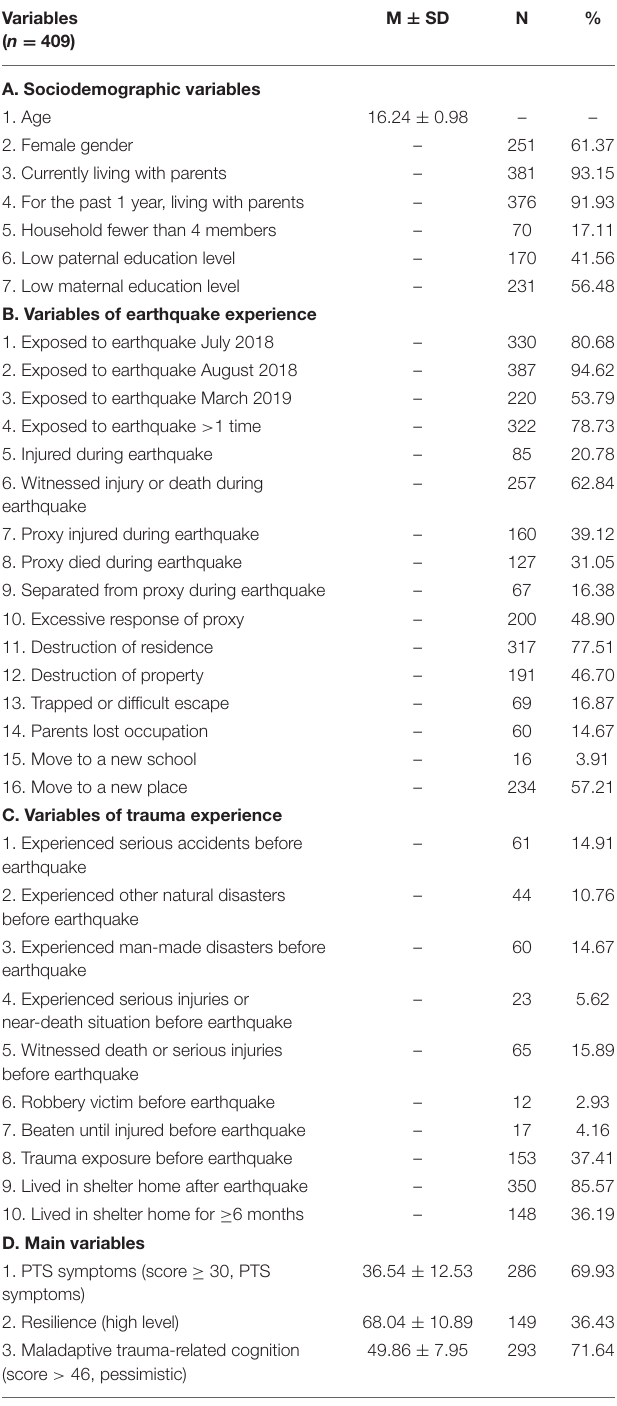
TABLE 1 | Descriptive statistics of all